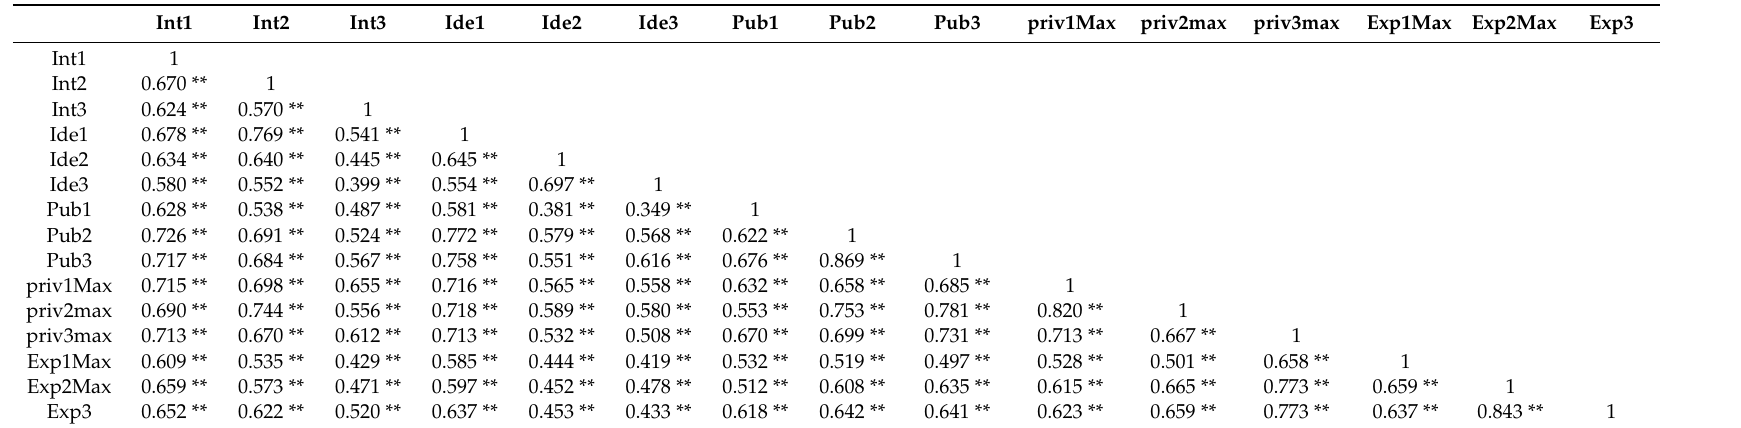
Table A9. Correlations between Items of